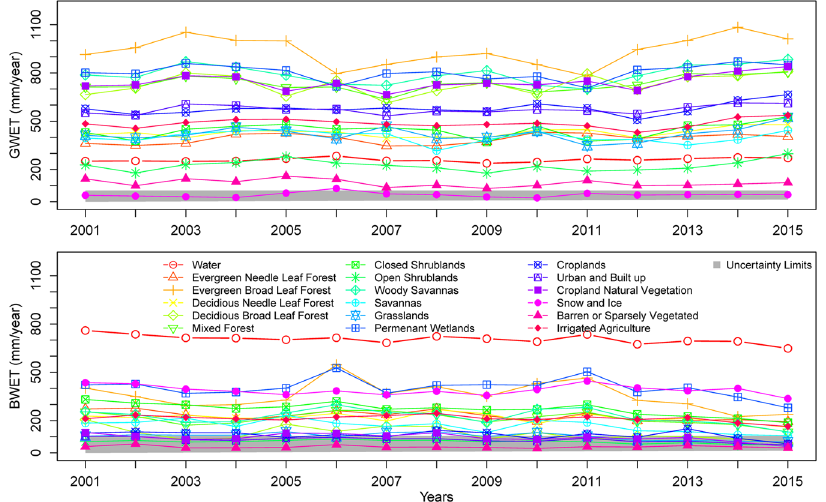
Figure 3. Average annual green water ET (GWET) and blue water ET (BWET) summarized for different land cover types. The gray polygon indicates the region where mean estimates of the BWET and GWET are within the range of modeling error/uncertainty (derived using post-bias correction RMSE). The figure was generated using R 3.3.0 software